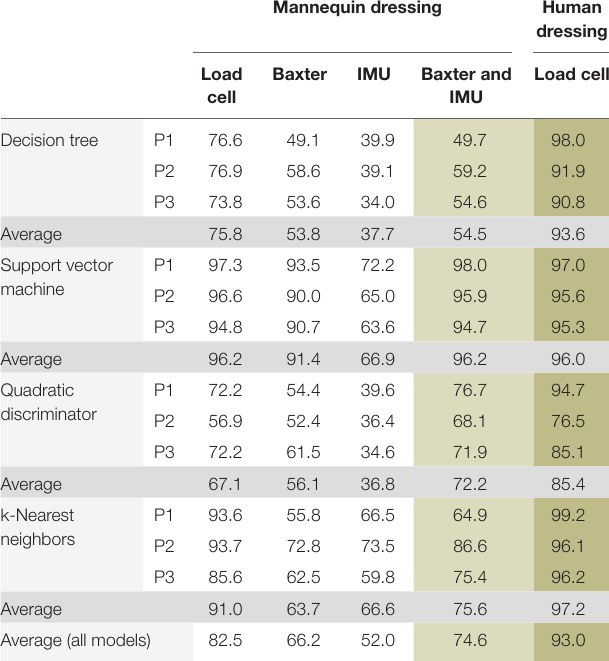
TaBle 3 | garment prediction accuracy (%) for mannequin and human dressing tests using filtered and first-order differential data as predictors for poses 1–3